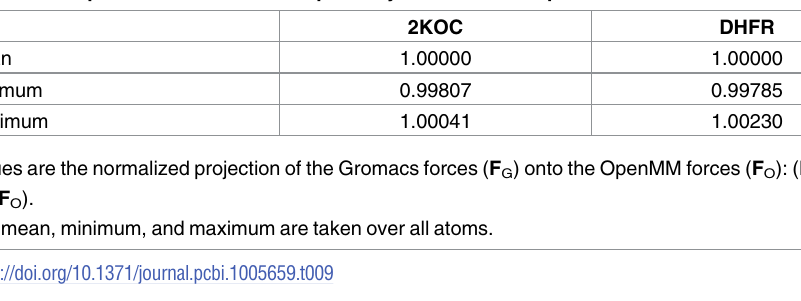
All values are in kJ/mol.